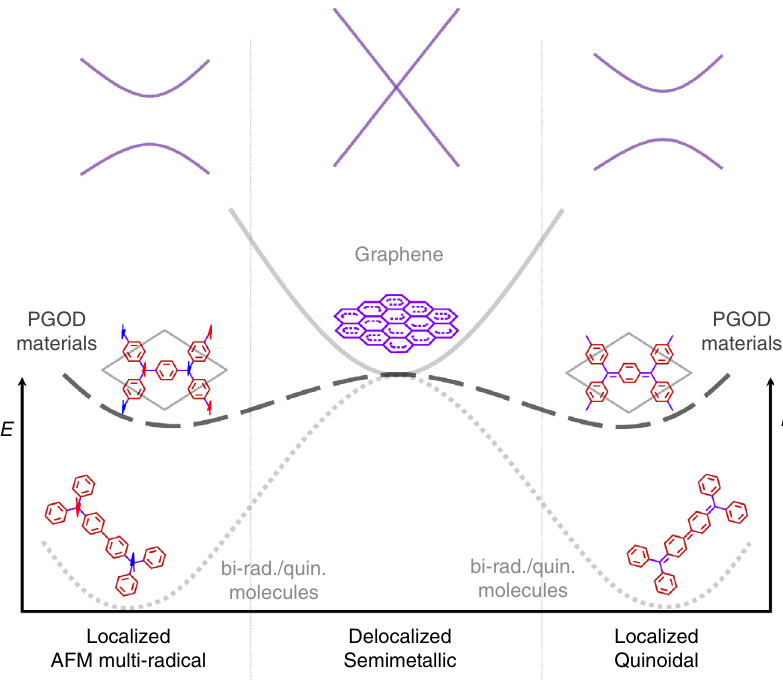
Fig. 6 PGODs as a bridge between graphene and molecular bi-radicals. PGOD materials (dashed black line) are systems with an electronic character that is intermediate between bi-radical/quinoidal molecules (dotted grey line) and graphene (continuous grey line). Schematic simpli fi ed electronic band structures of a generic PGOD material are represented by the solid purple lines above the corresponding electronic states. As such PGODs can exhibit both localised and delocalised solutions at very close energies, and thus possess an electronic tunability not easily obtainable from systems with dominant solutions (e.g., graphene and bi-radical/quinoidal molecules). Note: The relative positions of the different curves have been chosen for ease of illustration and should not be taken to indicate real energy differences between the three different